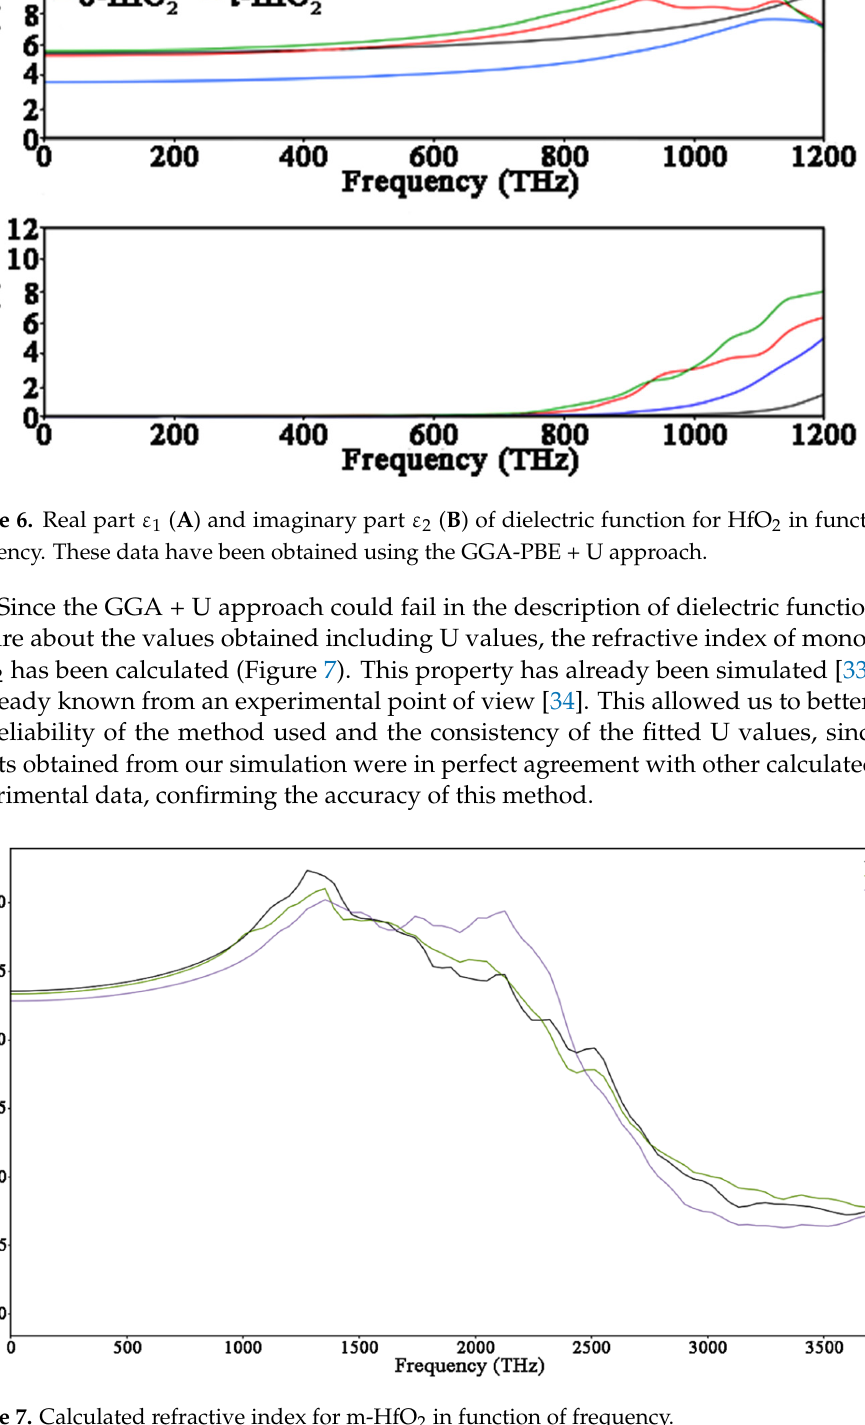
2 in function of